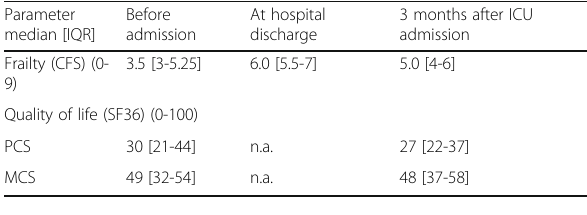
Table 2 (abstract 001752). Long-term